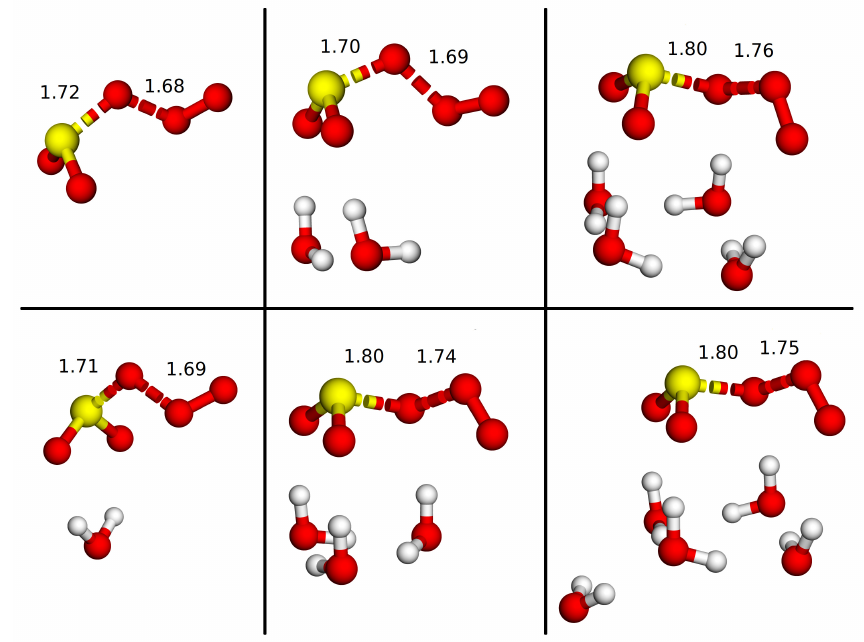
Fig. 4. Structures of the class of transition state complexes characterized by a strong network of hydrogen bonds. These are very similar to the reactant complexes, shown in Fig. 2, and are denoted “dense” due to the dense water structures. The dashed bonds indicate the bonds which are active in the reaction. Bond lengths are given in ˚A. Sulfur (yellow), oxygen (red), hydrogen (white).